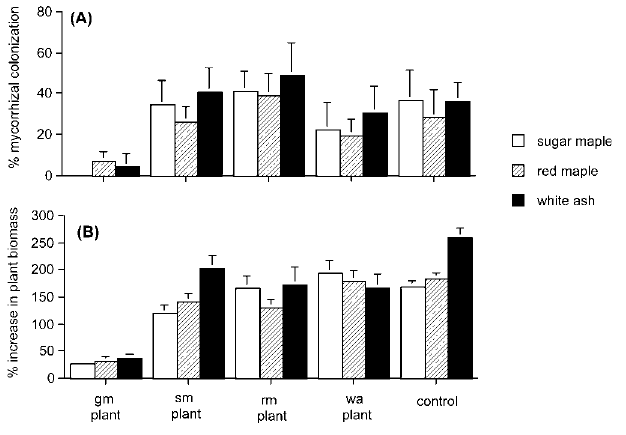
The effect of soils conditioned with garlic mustard Al. petiolata (gm), sugar maple (sm), red maple (rm), or white ash (wa) on (A) mycorrhizal